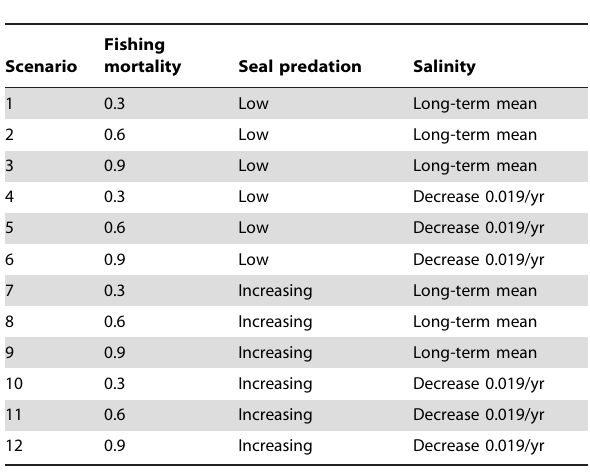
Table 1. Scenarios employed to simulate cod population dynamics in the eastern Baltic Sea (ICES Subdivisions 25–32) during the 21 st century for different combinations of exploitation, salinity (as a consequence of expected climate change) and seal